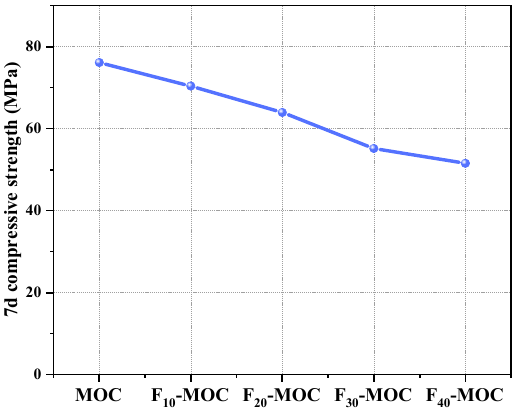
Figure 3. Compressive strength of fly ‐ ash–MOC composite binary system.